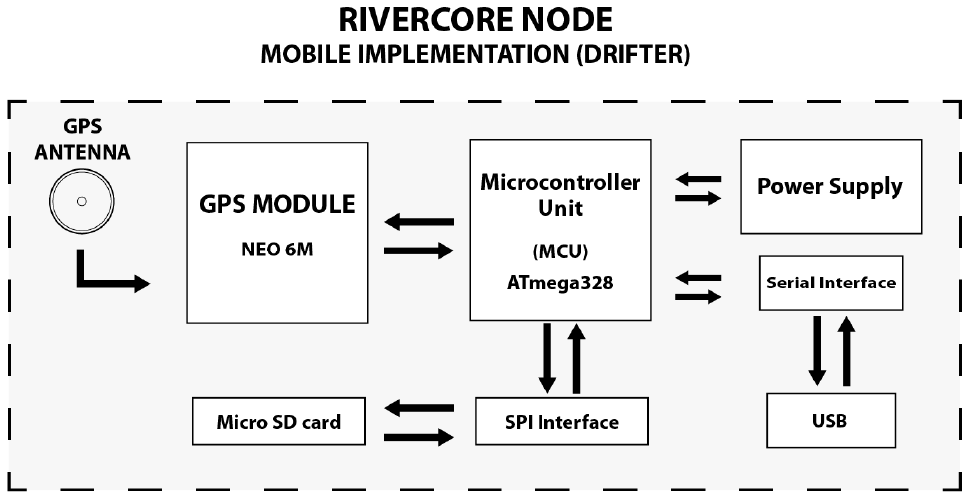
Figure 4. RiverCore mobile node components.